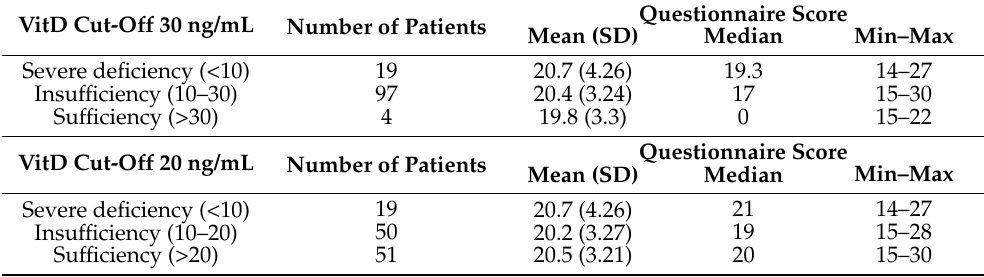
Table 3. Description of questionnaire scores by vitamin D status, considering serum levels of both 30 and 20 ng/mL as cut-offs for VitD insufficiency.